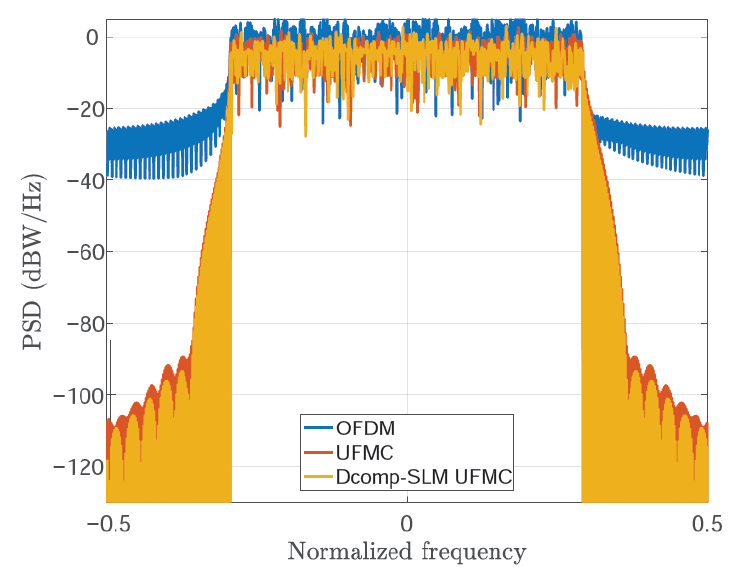
Figure 9. The power spectral density (PSD) of OFDM, UFMC, and the proposed Dcomp-SLM